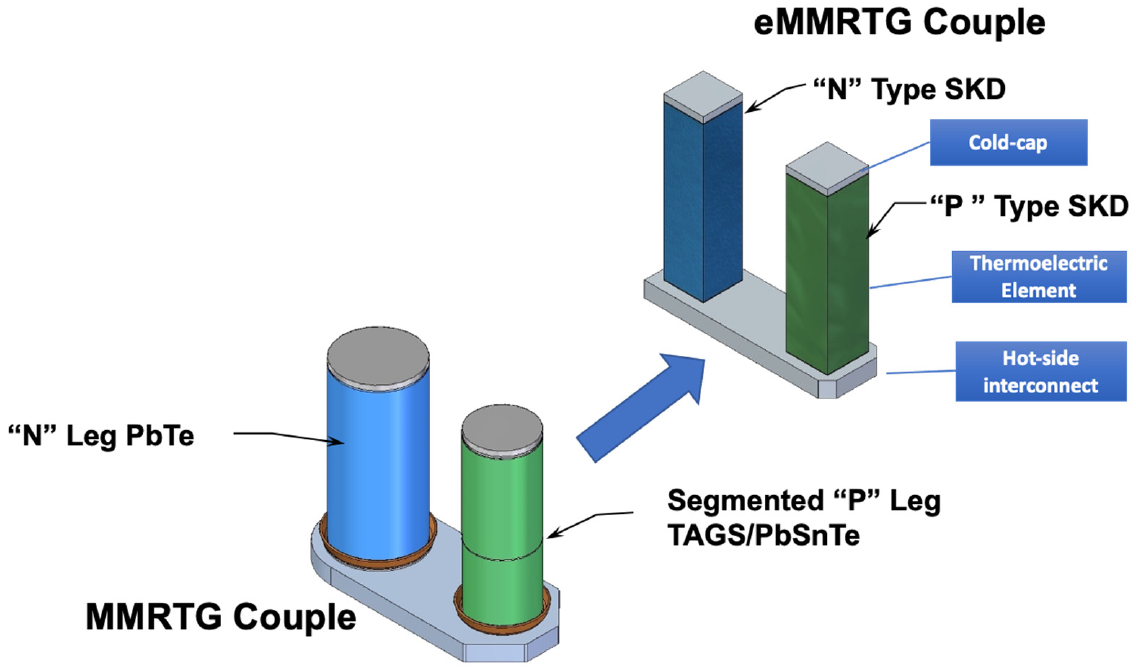
Figure 9. Illustration of the MMRTG and eMMRTG thermoelectric couples.